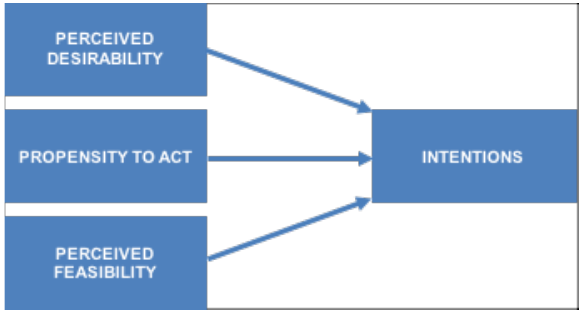
Fig. 1 : The Shapero-Krueger model of entrepreneurial intentions (modified from Krueger et al.